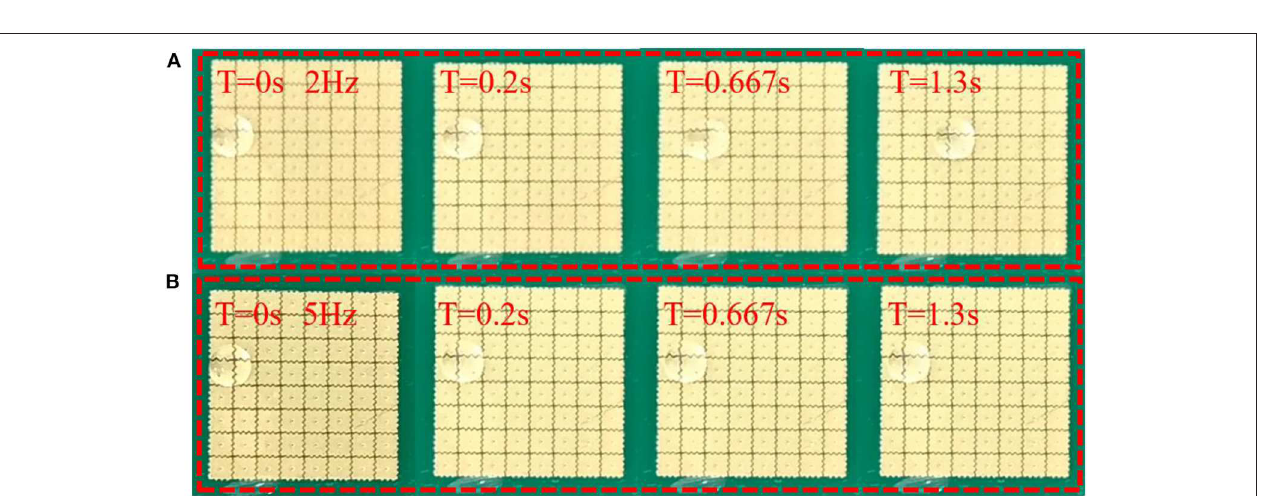
FIGURE 14 | Position comparison of droplets which have the same volume during the driving process when switching frequencies between two adjacent electrodes are 5 and 10Hz. (A) When the electrode switching frequency is 5Hz, the droplet is driven from the initial position to the third electrode after 0.3s. (B) When the electrode switching time is 10Hz, the droplet is driven from the initial position to the fourth electrode after 0.3s.